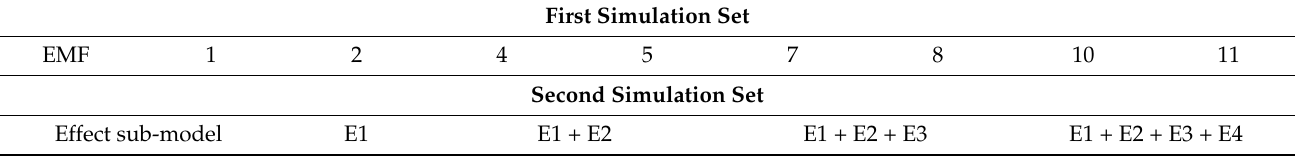
Table 1. Simulation sets performed in the study. EMF = exposure magnification factor. E1 = GUTS model for juveniles and adults; E2 = TKTD model on egg production; E3 = GUTS model on hatching; E4 = indirect